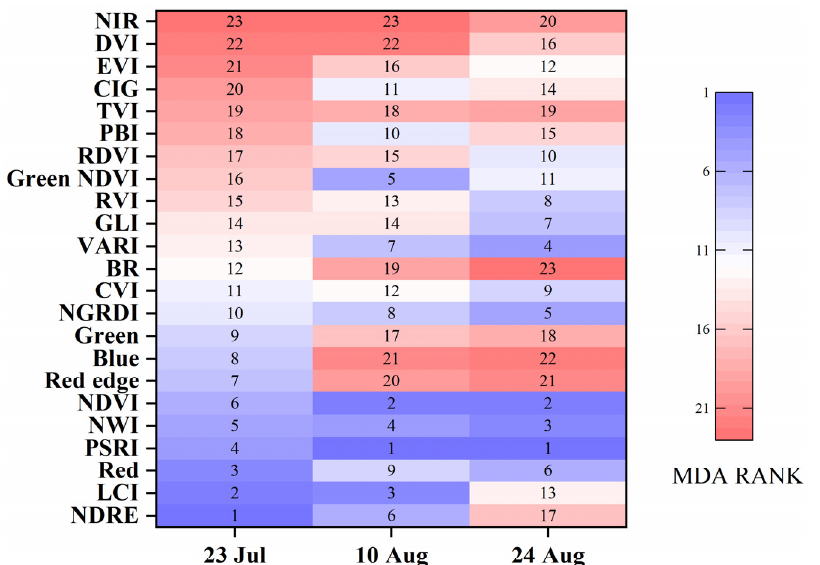
Figure 10. Parameter importance ranking. The numbers in the picture represent the MDA rank of each parameter.